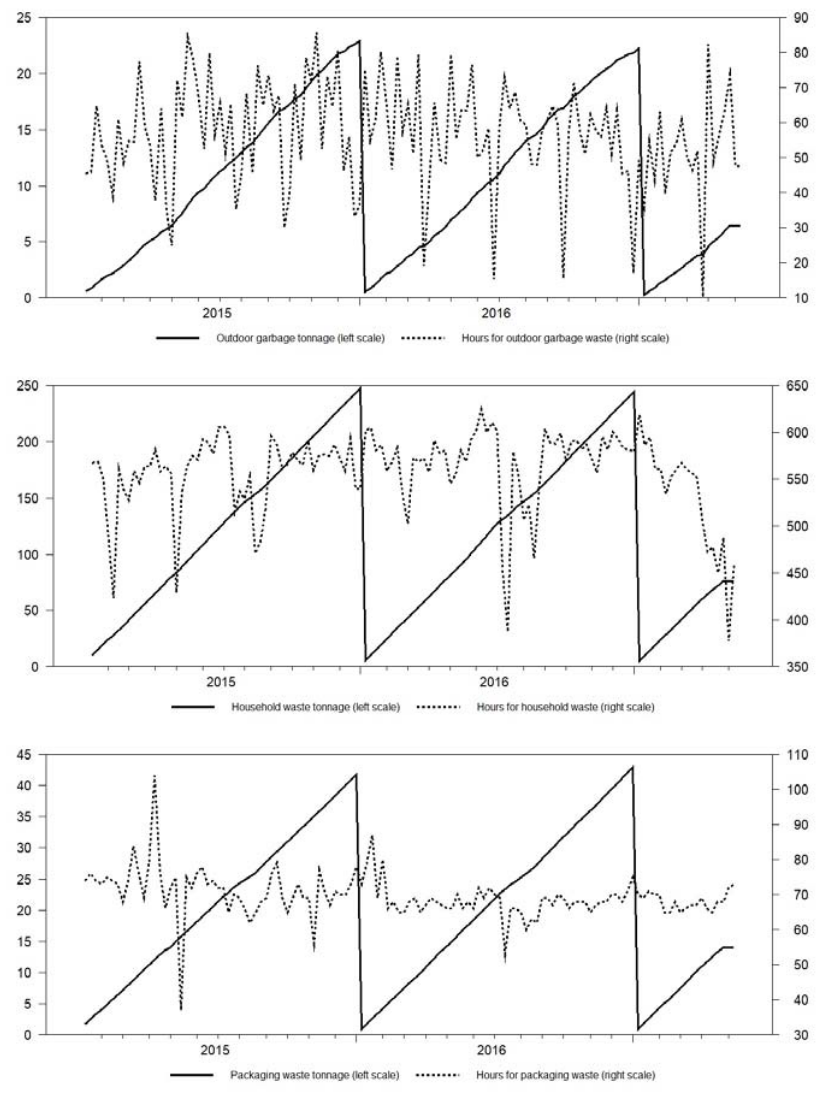
Fig. 1. Per capita weekly waste tonnage and